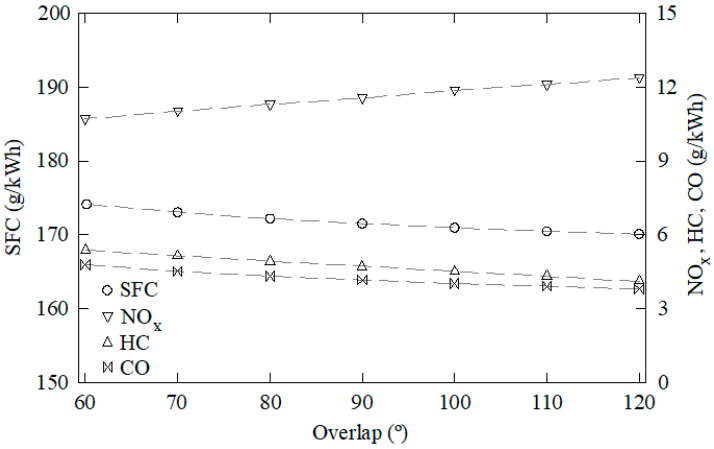
Figure 5. SFC, NO x , CO, and HC emissions against the overlap timing. EGR rate = 0, water to fuel ratio = 0, intake valves closing = 568 ◦ , cooling water temperature = 76 ◦